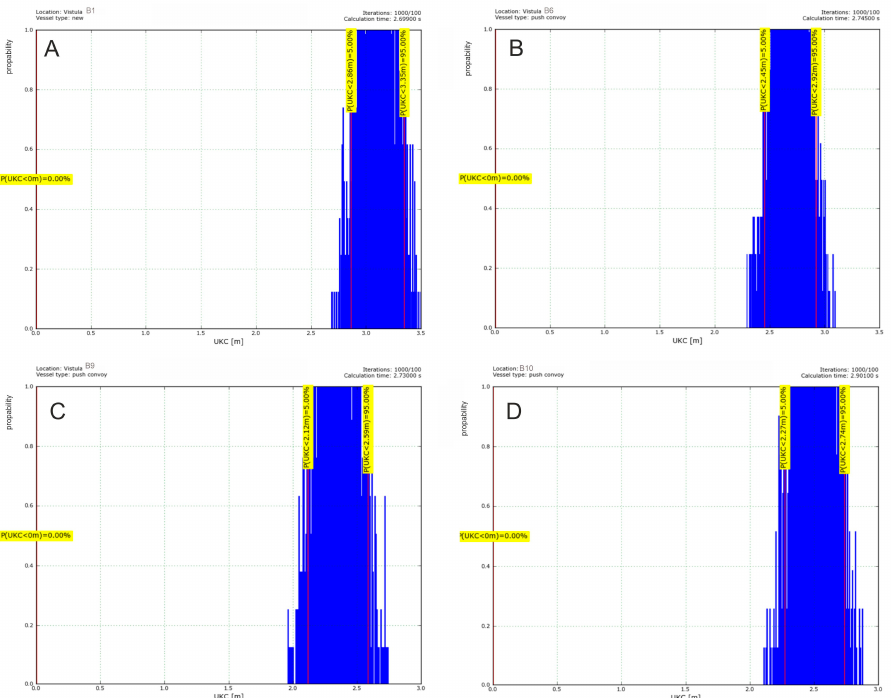
Figure 6. Results of a probabilistic model of UKC application. Histograms show a simulated under keel clearance for LWL limit values for bridges: ( A ) B1, ( B ) B6, ( C ) B9, and ( D ) B10.